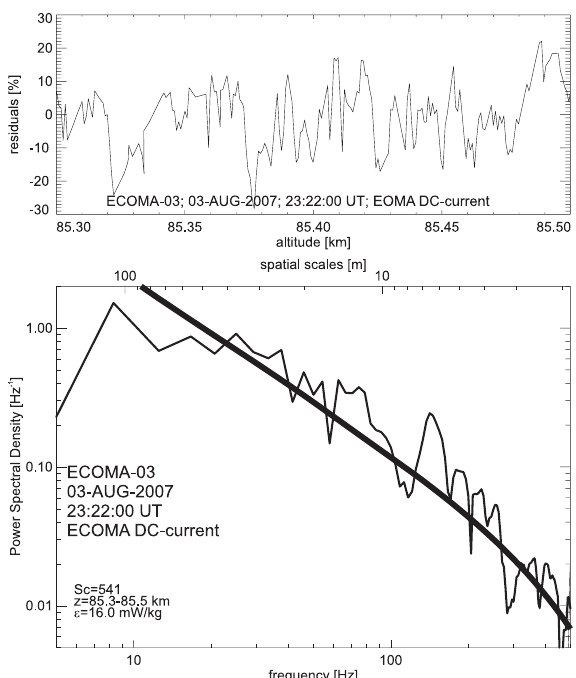
Fig. 6. Upper panel: relative density fluctuations (residuals) of the charged particle density measured in situ between 85.3 and 85.5km height. Lower panel: Power spectral density of the residuals (thin line) and the best fit of the model by Driscoll and Kennedy (1985). The energy dissipation rate ε = 16mW/kg was taken from radar measurements. The derived Schmidt number Sc = 541.